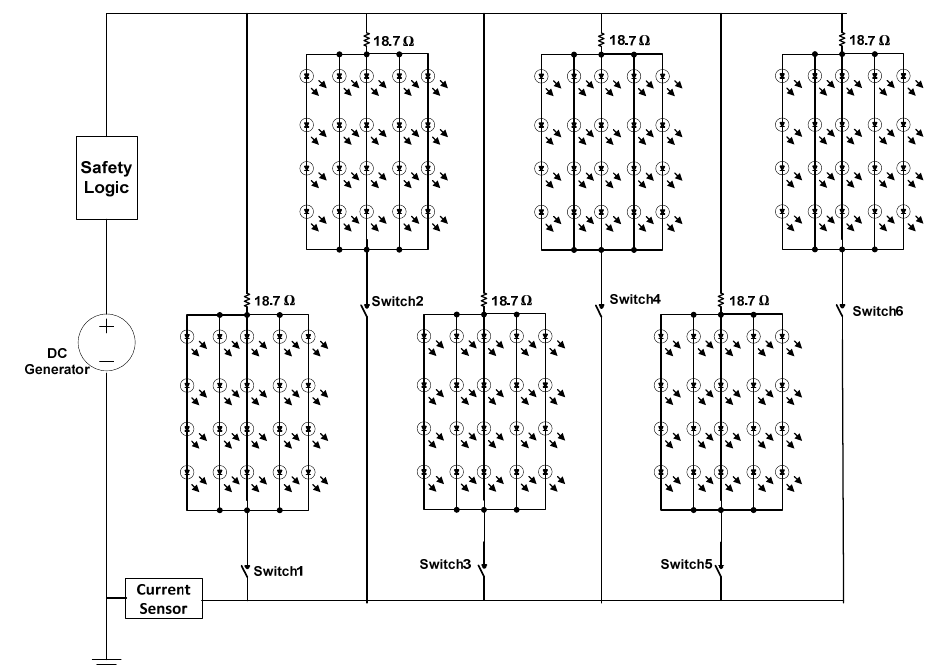
Figure 2. Schematic of the load